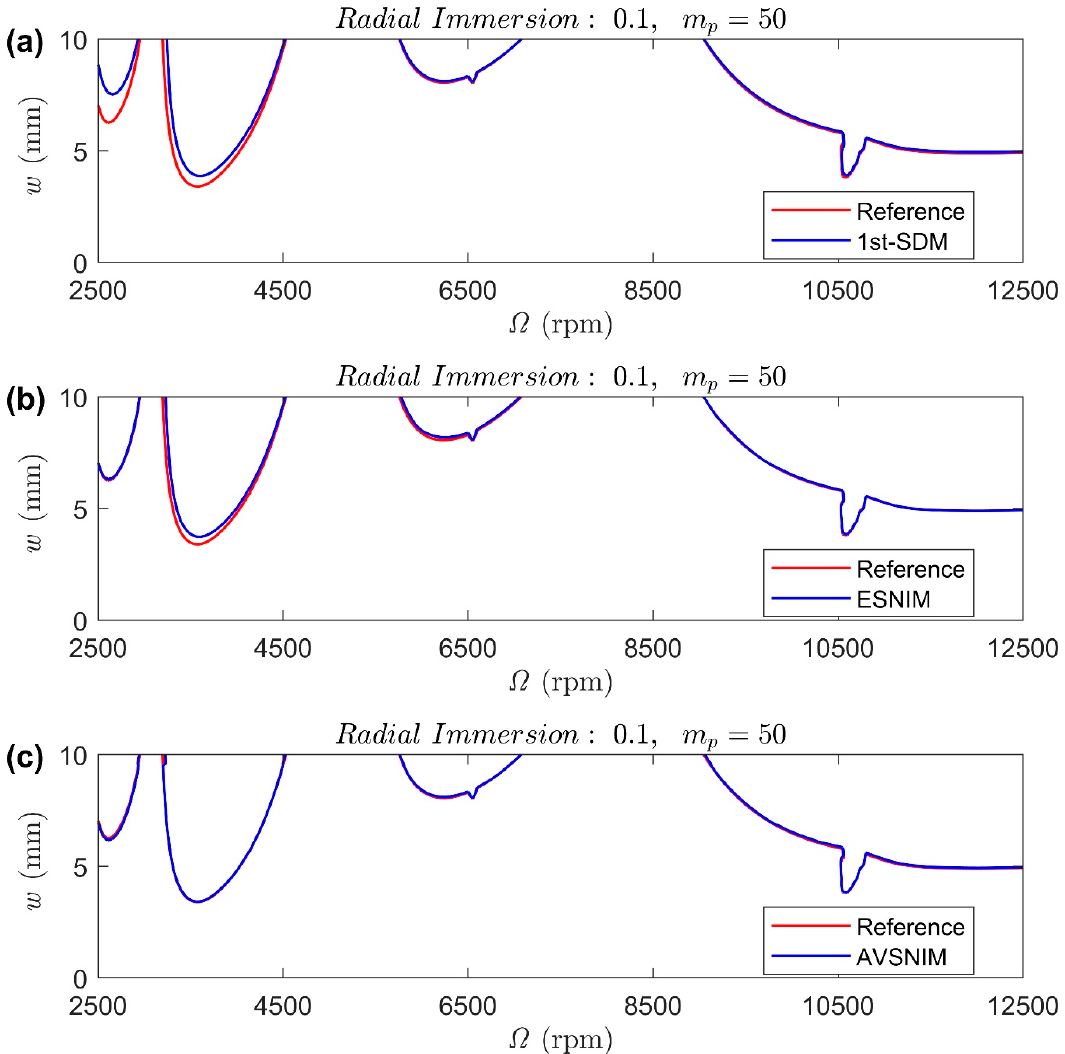
m = , ( a ) SLD obtained p